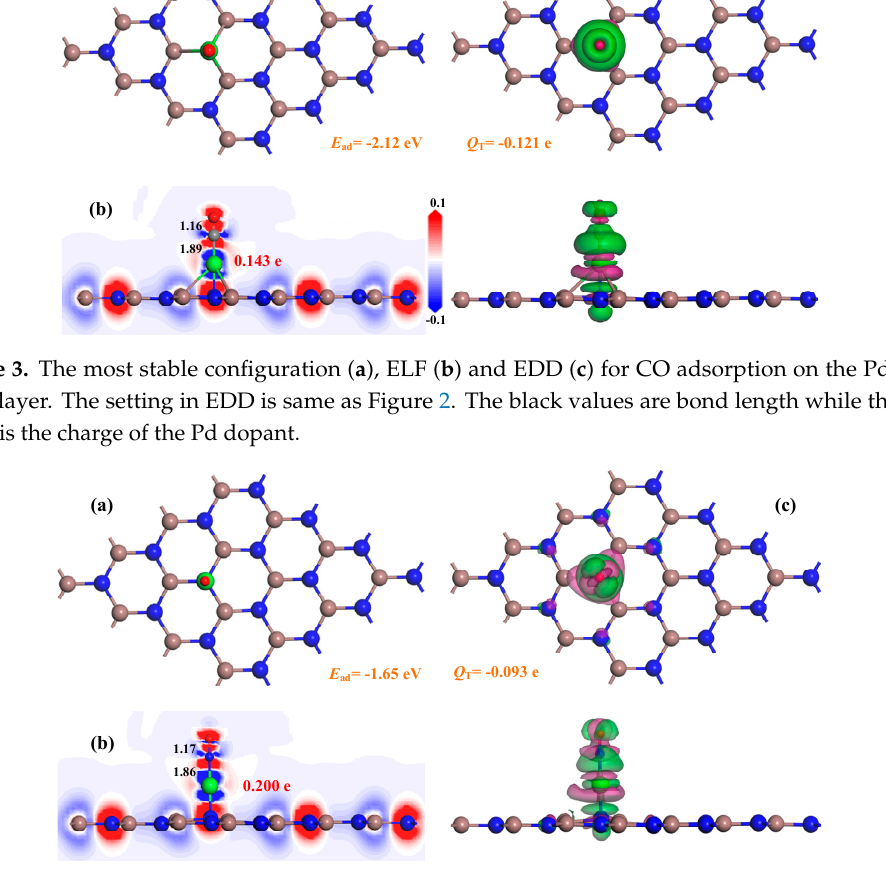
Figure 4. The most stable configuration ( a ), ELF ( b ) and EDD ( c ) for NO adsorption on the Pd-InN monolayer. Other settings are same as Figure 3.